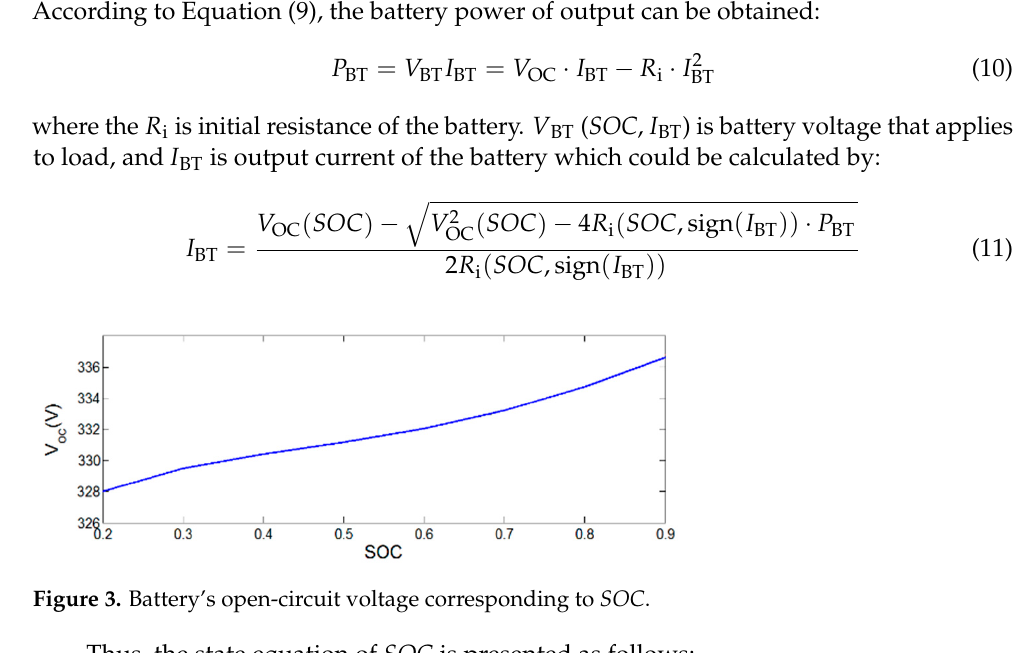
Figure 3. Battery’s open-circuit voltage corresponding to SOC.